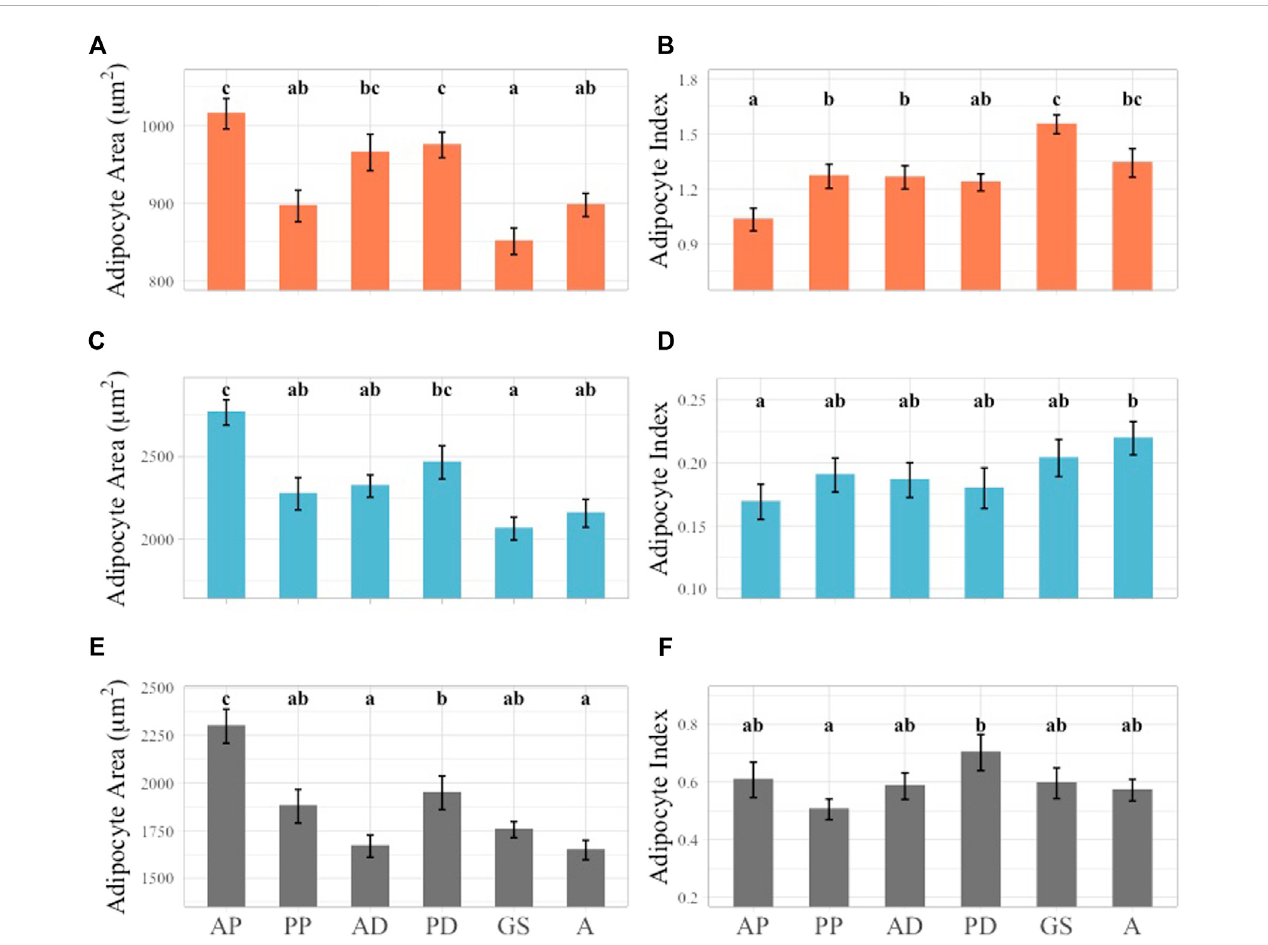
FIGURE 6 LinearmixedeffectmodelofaverageAAandAIacrossgirthaxessubsetbylayer.Outerlayerdatashowninorangeattoprowof fi gurepanel,middlelayer shown in blue in middle row of fi gure panel, inner layer shown in gray in bottom row of fi gure panel. Signi fi cant differences identi fi ed by lower case letters above each bar graph. Groups with any shared letters are not signi fi cantly different to each other. Error bars represent standard error. (A) Outer layer AA , (B) Outer LayerAI, (C) MiddlelayerAA, (D) MiddleLayerAI, (E) InnerlayerAA, (F) Inner LayerAI.Girthaxesfor allplots shown usingonetotwoletteridenti fi er along X -axis of inner layer Panel 6E, F, “ AP ” = Anterior Pectoral, “ PP ” = Postersior Pectoral, “ AD ” = Anterior Dorsal, “ PD ” = Posterior Dorsal, “ GS ” = Genital slit, “ A ” =